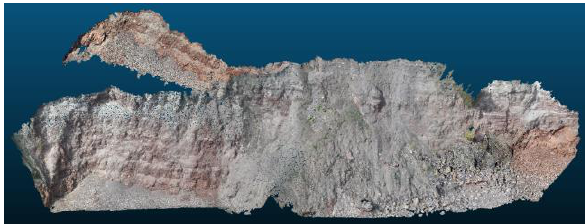
Figure 8. Multiple Block Point Cloud Showing the Effect of Drifting on the Inexpensive GNSS Sensors 3. EVALUATING THE GEOMETRIC PRECISIONS OF THE POLE SURVEY FOR CLIFF SURFACE DEFORMATION STUDIES The different point clouds generated should be geometrically Comparisons were on four different point clouds obtained